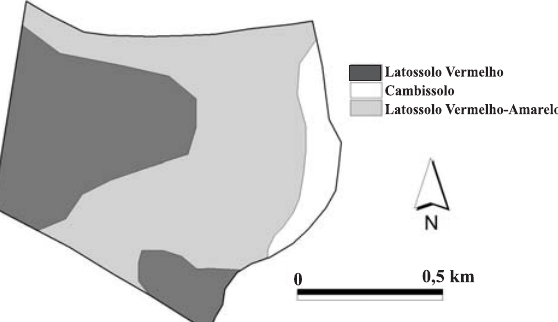
Figura 1. Mapa planialtimétrico da gleba estudada.